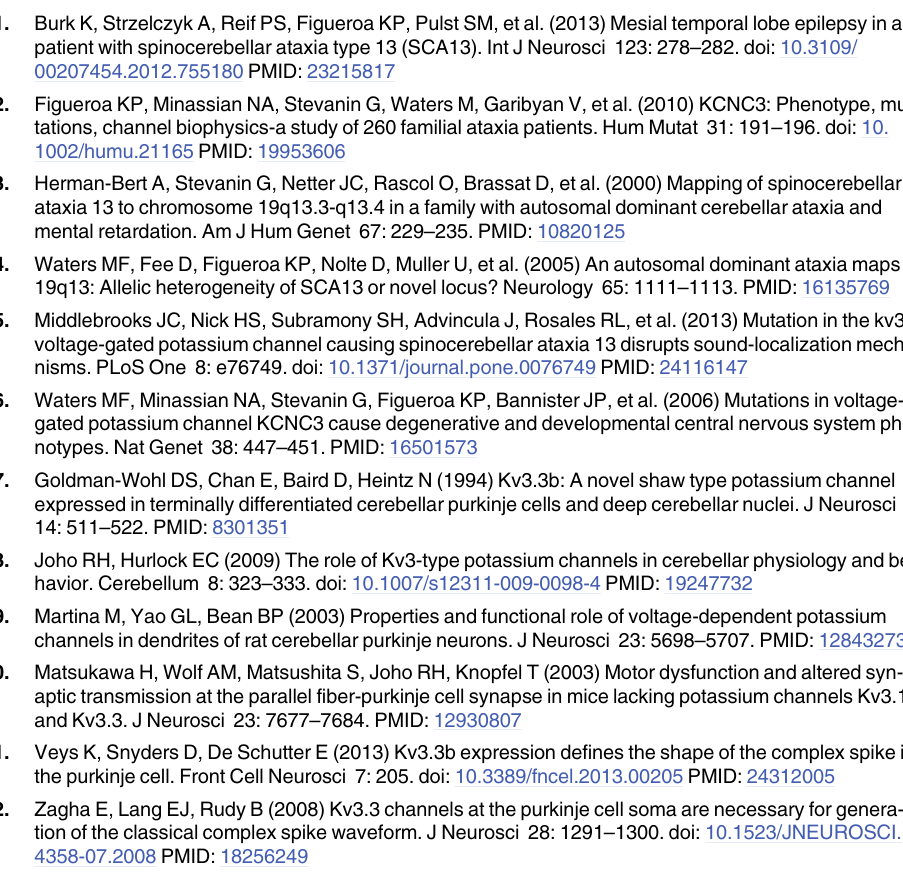
S1 Table. Primer list used for KCNC3 sequencing. S2 Table. Primers pairs used to generate KCNC3 mutants and to subclone KCNC3 cDNA into pEGFP-N1. S3 Table. Genetic and clinical information of newly identified KCND3 missense